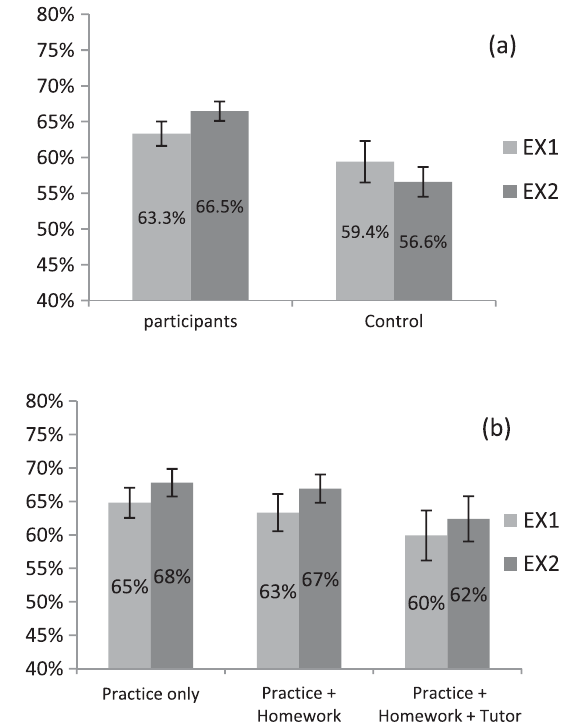
FIG. 4. (a) First and second midterm exam scores (before and after the treatment) from paticipants who completed three treat- ment sessions along with the control group. (b) First and second midterm from three treated groups.